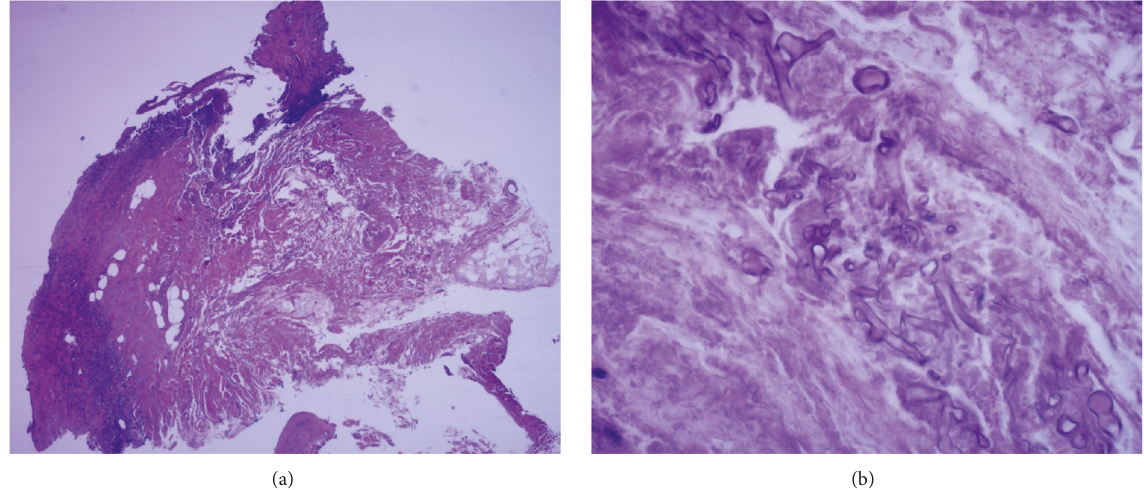
Figure 2: (a) 20x H/E. Skin and subcutaneous adipose tissue with ulcer and tissue necrosis. (b) 400x PAS. Septate and fragmented hyphaes of medium thickness in dermis with invasion of blood